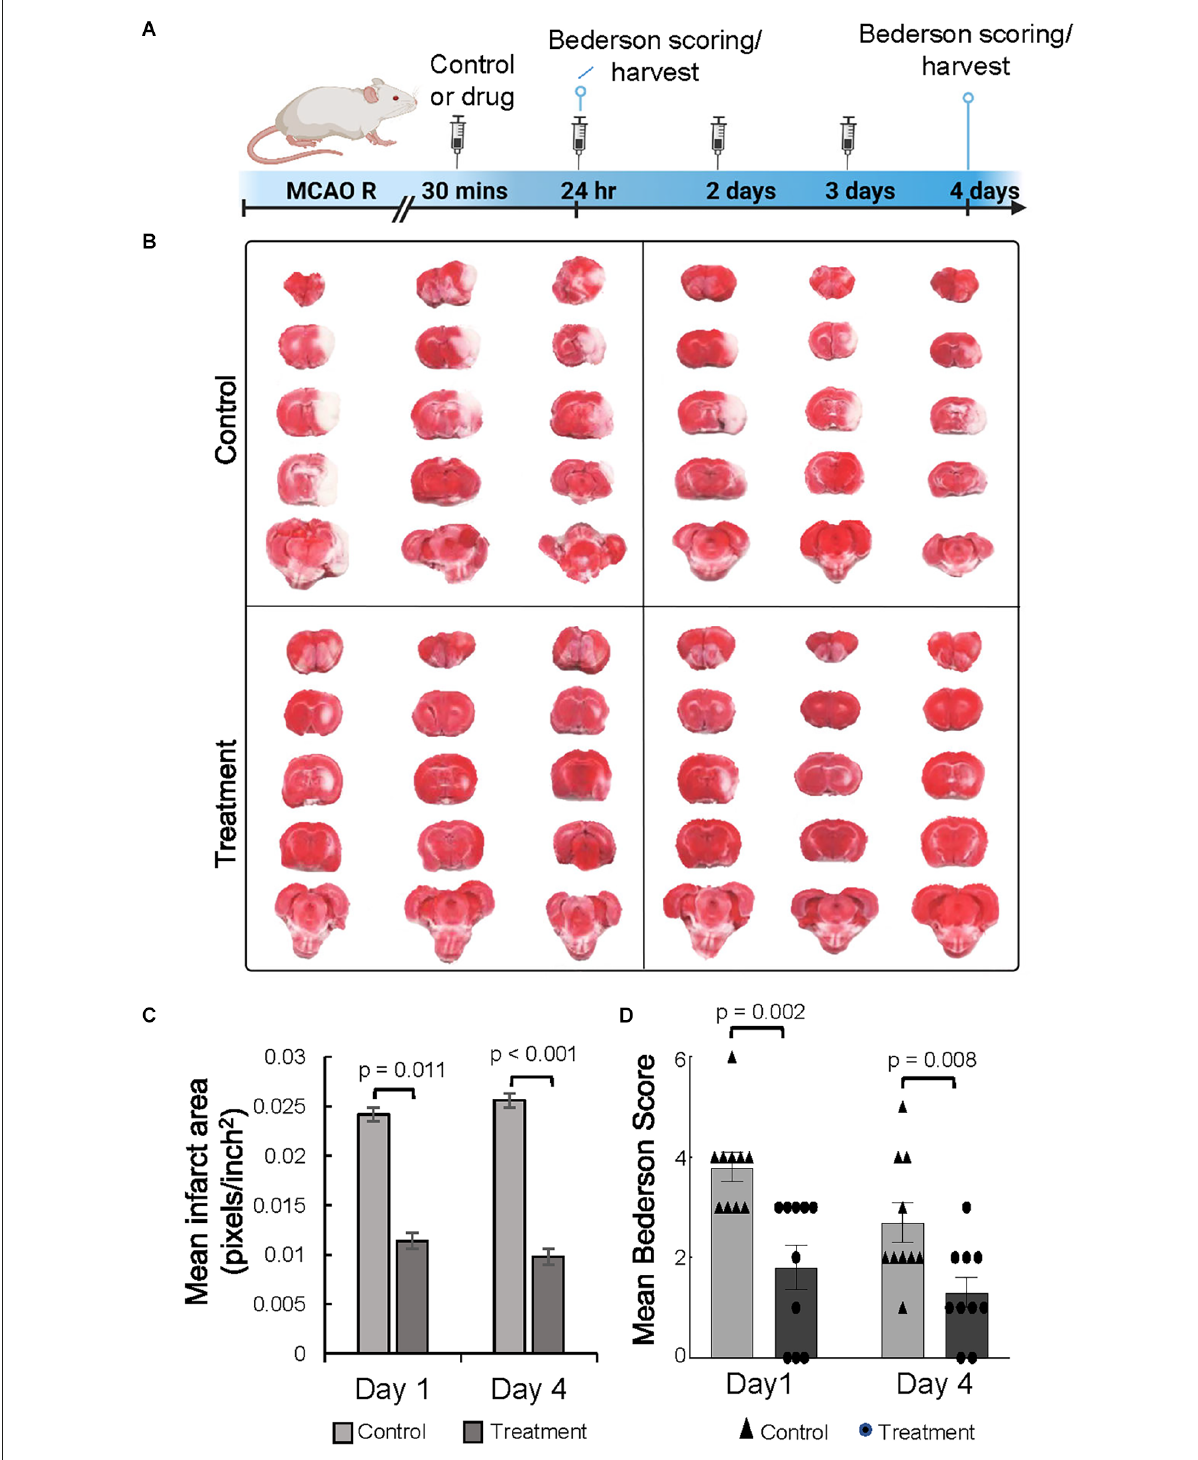
FIGURE1 The SRC activator 10-1 attenuates cerebral ischemic injury and performance activity post-MCAO R. (A) Schematic representation of experimental procedures. Rats were injected with 10-1 (20 mg/kg) or control 30 min after a 90-min occlusion of the middle cerebral artery and every 24 h up to harvest at day 1 ( n = 20) and day 4 ( n = 20) after surgery. (B) Brains were harvested and stained with TTC to delineate and calculate infarct size. (C) Mean area of infarct was calculated at day 1 and day 4 post-MCAO R. (D) Neurological testing was done 24 h and 4 days after stroke onset using a modified Bederson score. n = 10 control and n = 10,